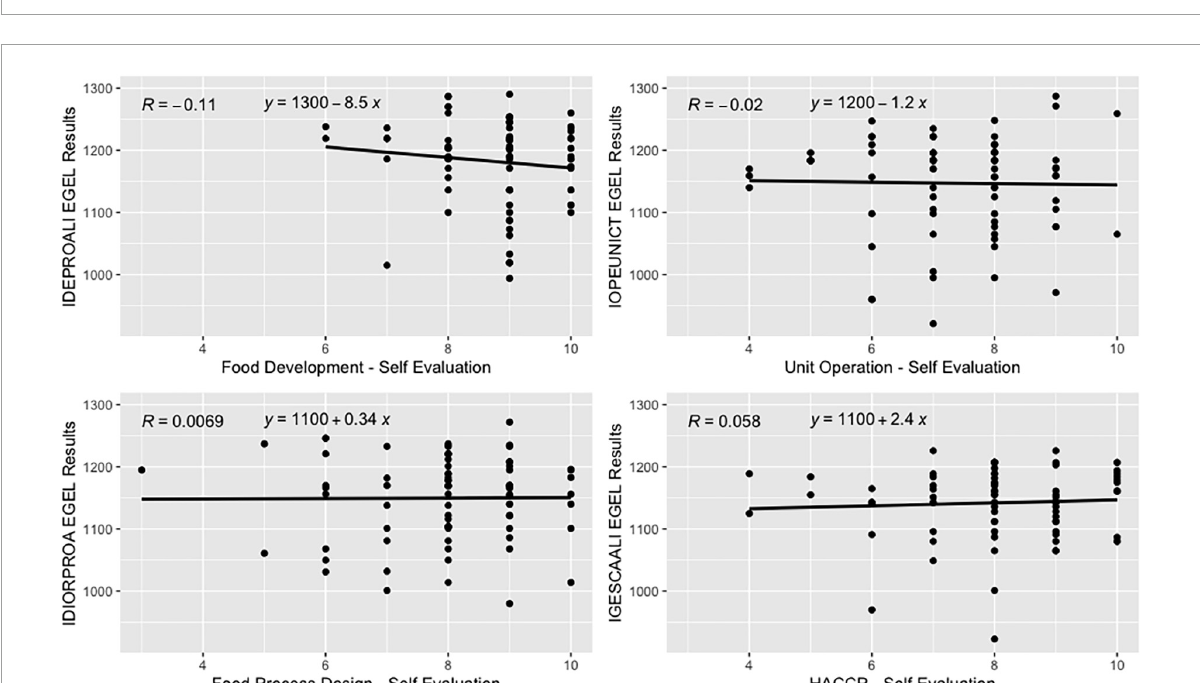
FIGURE8 EGEL (General graduation Exam by the National Centre of Evaluation) results and self-evaluation of academic categories mean results by EGEL section. IDEPROALI = Food Product Development ( R = − 0.11); IOPEUNICT = Unit Operations for the Conservation or Transformation of Food ( R = − 0.02); IDIORPROA = Design and Operation of Food Processes ( R = 0.0069); and IGESCAALI = Food Quality Management ( R =